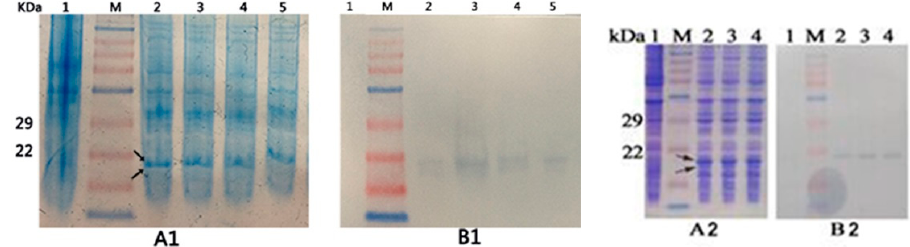
Figure 3. SDS-PAGE and Western blotting of E. coli BL21 and the recombinant strains. Line 1–5 in A1 and B1 is E. coli BL21, B, BU, BS, and BUS, respectively; Line 1–4 in A2 and B2 is E. coli BL21, BU, B(C82A)U and B(C153A)U, respectively. Arrows indicate the band of phycocyanin at about 18 KDa; A1, B1, A2 and B2 show that the blank E. coli BL21 has no immunoreactive band, whereas B, BU, BS, BUS, B(C82A)U and B(153A)U all have immunoreactive bands at about 18 kDa.